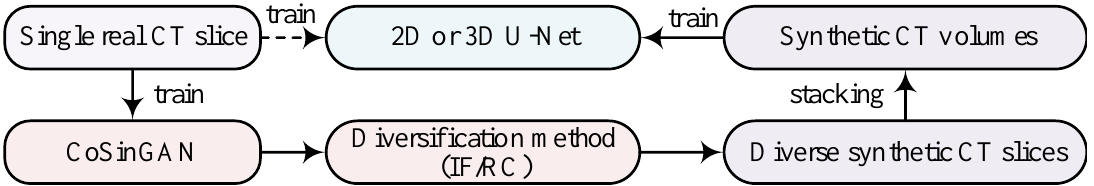
Figure 13. Illustration of the workflow of learning 2D or 3D U-Net from a single CT slice for automated lung and infection segmentation by using